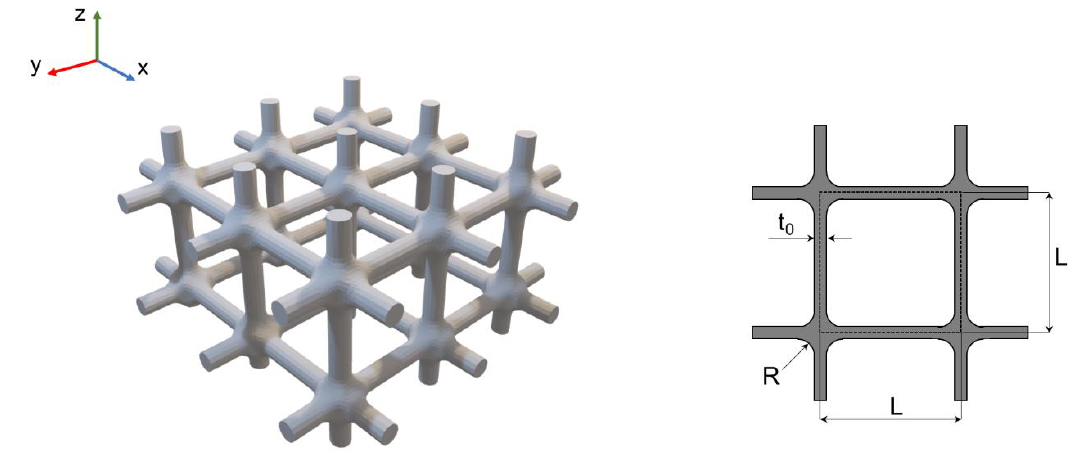
Figure 1. A 3D model of the L-PBF Ti6Al4V simple cubic lattice structure (on the left) and the simple cubic lattice unit (on the right). T0 is the diameter of the strut (670 µm), R is the radius of the fillet at the junction (600 µm), and L represents the side of the cell unit (4 mm).